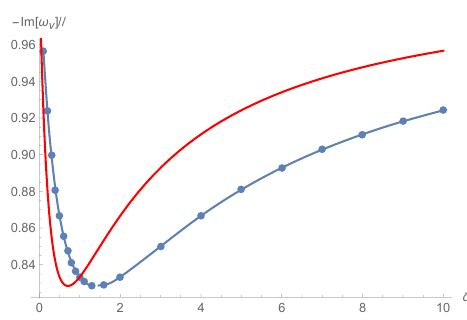
Figure 10 . The vector-type QNMs of the slowly rotating black hole in EGB theory. The dotted line is the result obtained by numerically solving the master equation. The solid line is the numerical evaluation of